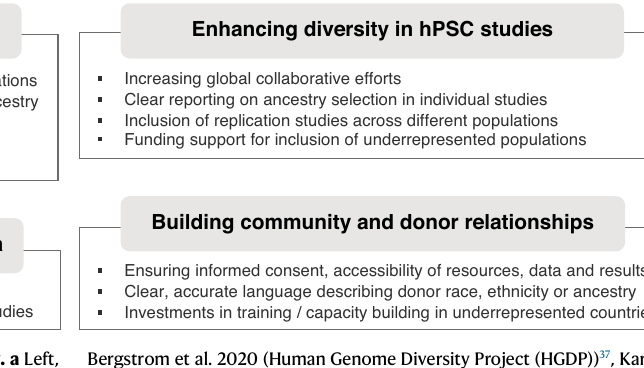
Bergstrom et al. 2020 (Human Genome Diversity Project (HGDP)) 37 , Karczewski et al. 2020 (gnomAD) 38 and Smedley et al. 2021 (100,000 Genomes Pilot) 39 . b